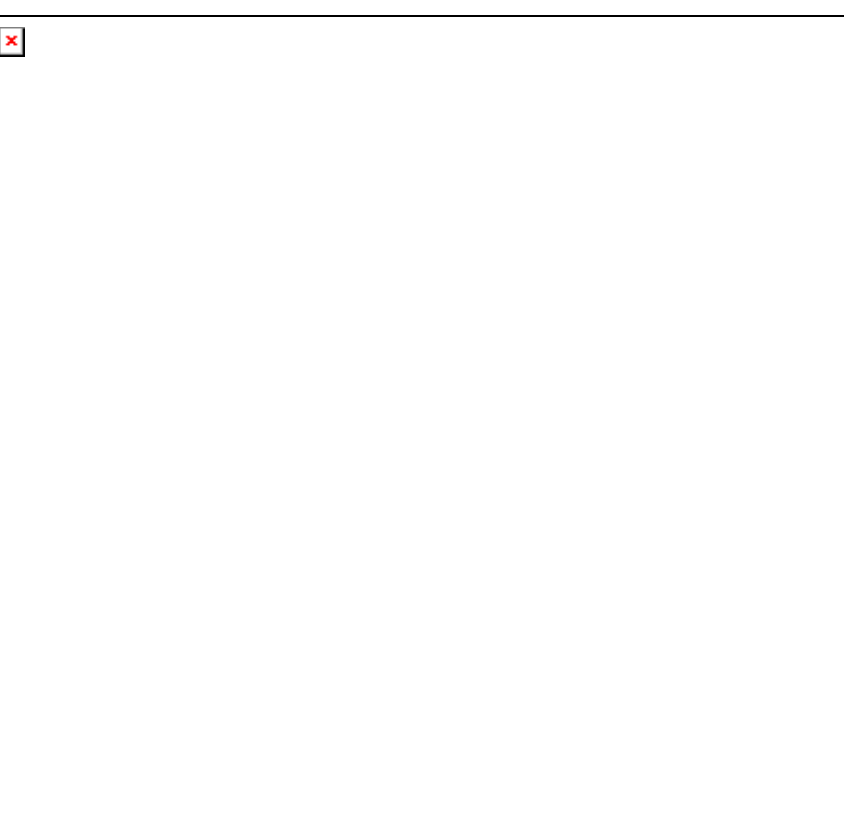
Figure 3: Sketch of the structure of the Haarlem All Glass